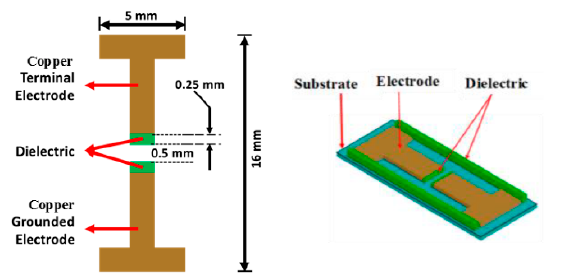
Figure 1. Microplasma discharge device electrode